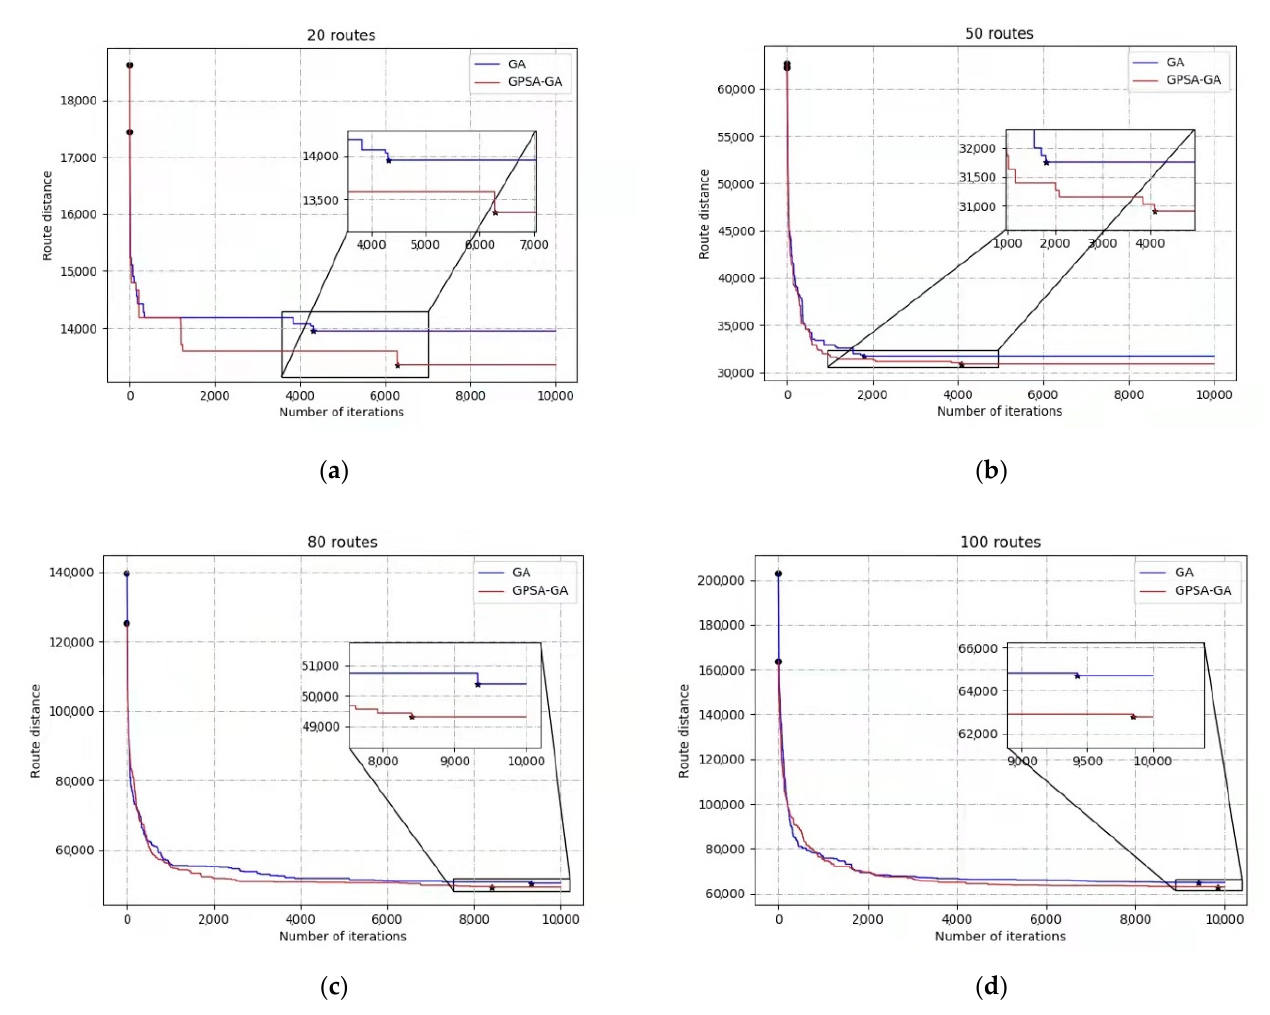
Figure 9. Optimal value convergence trend. ( a ) 20 paths, ( b ) 50 paths, ( c ) 80 paths, ( d ) 100 paths. Table 3. Scan-type path